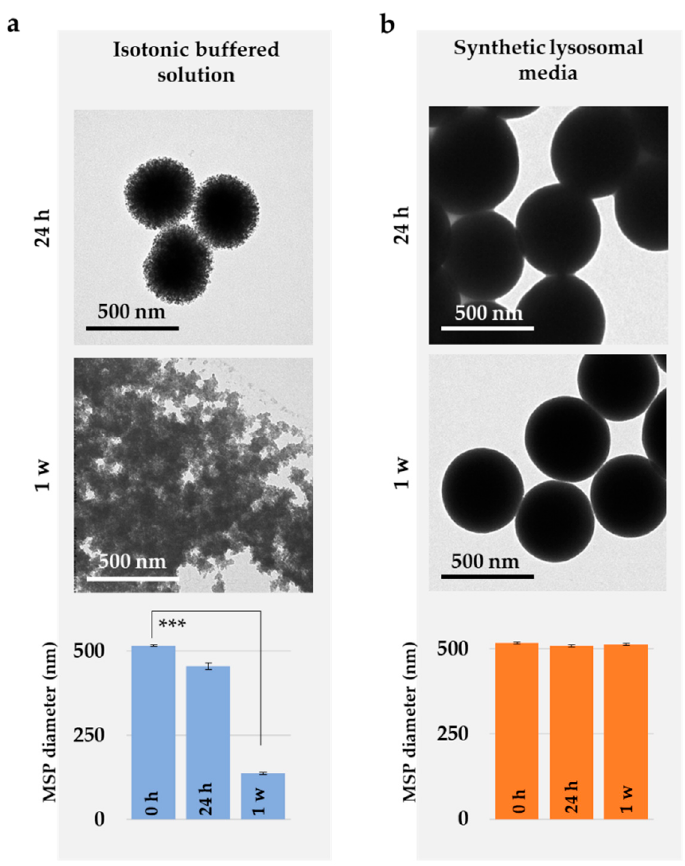
Figure 5. Degradation of MSP in synthetic biomimetic solutions. Representative TEM images of MSP after incubation for 24 h and 1 week in ( a ) isotonic buffered solution mimicking the intra/extracellular milieu (PBS) or ( b ) synthetic lysosomal media. Statistical evaluation of the size change in particle diameter upon incubation in media ( *** p < 0.005). Control particles are shown in Figure S1.